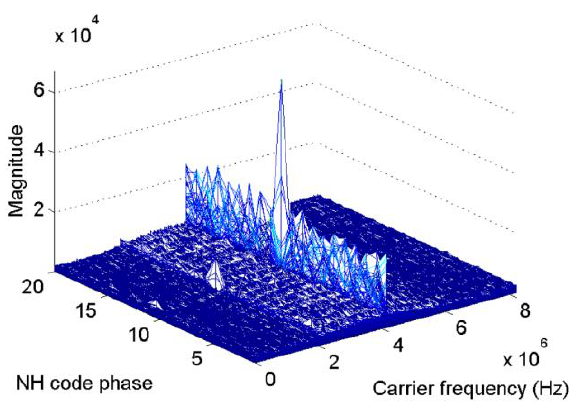
Figure 5. Frequency recalculation result against the NH code phase and carrier frequency.